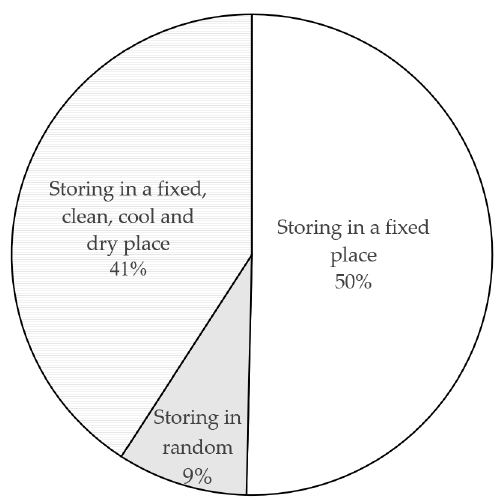
Figure 5. The situation of drug storage in